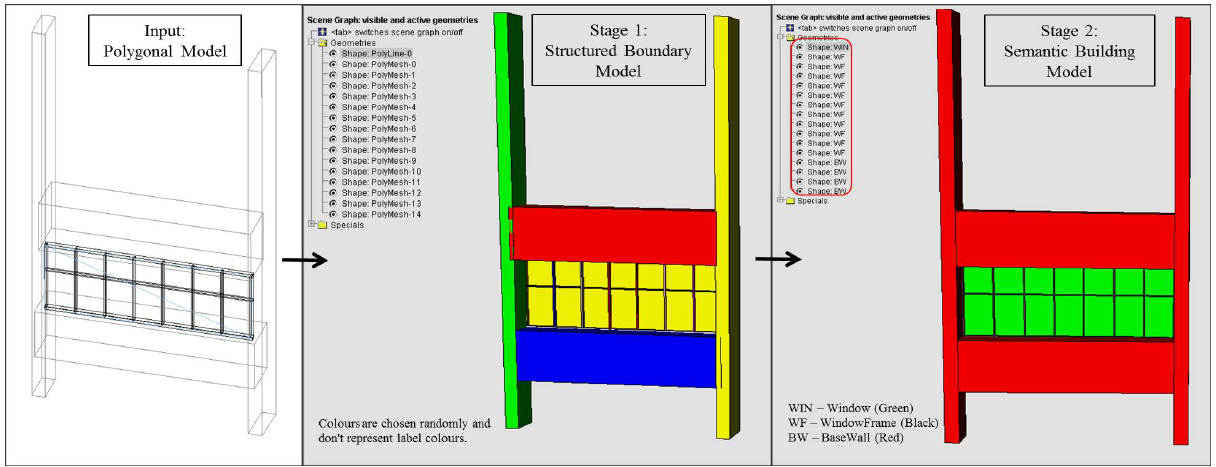
Figure 2: Diagram of grammar-based automatic building model reconstruction process.